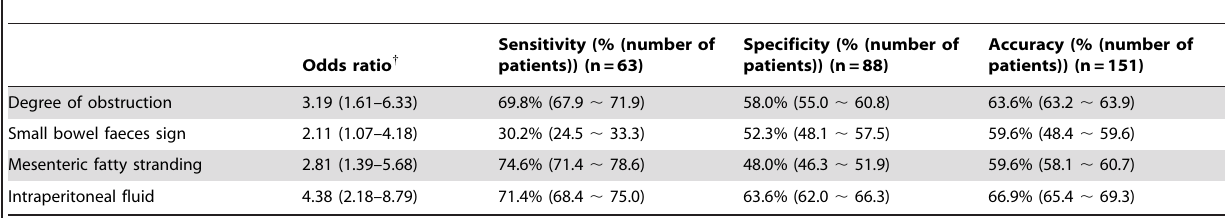
Table 3. Sensitivity, specificity, accuracy values and odds ratio of MDCT features for predicting adhesion-related SBO requiring surgery.